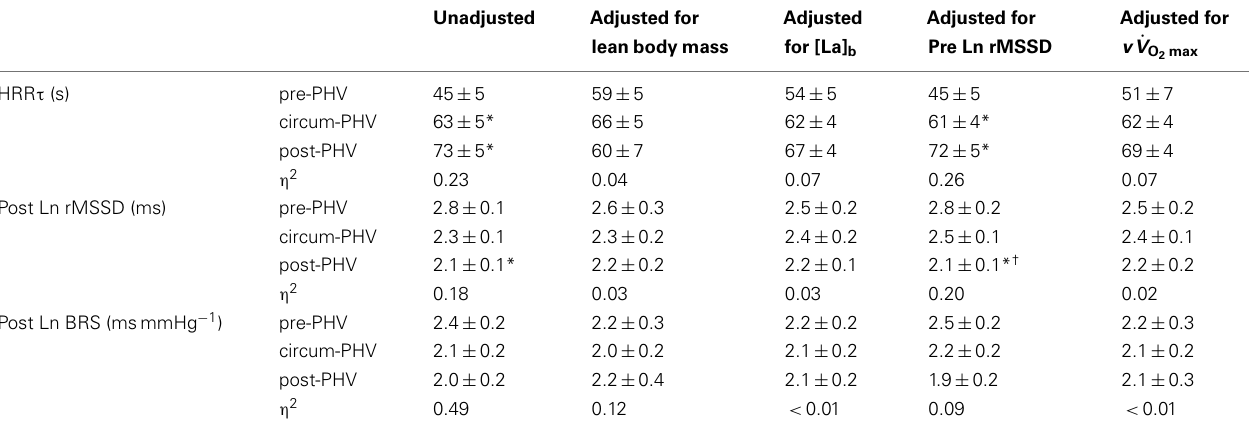
Table 5 | Indices of post-exercise parasympathetic reactivation in highly trained young soccer players grouped according to maturity